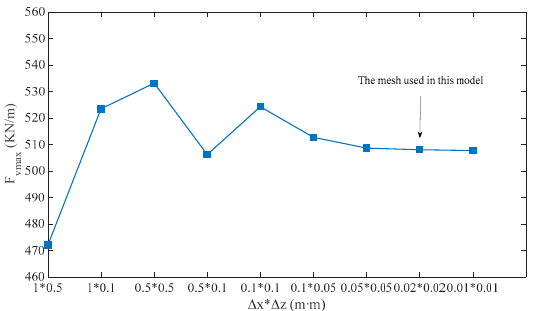
Figure 6. Validations of the maximum uplift force ( F v ma x ) for various mesh systems.